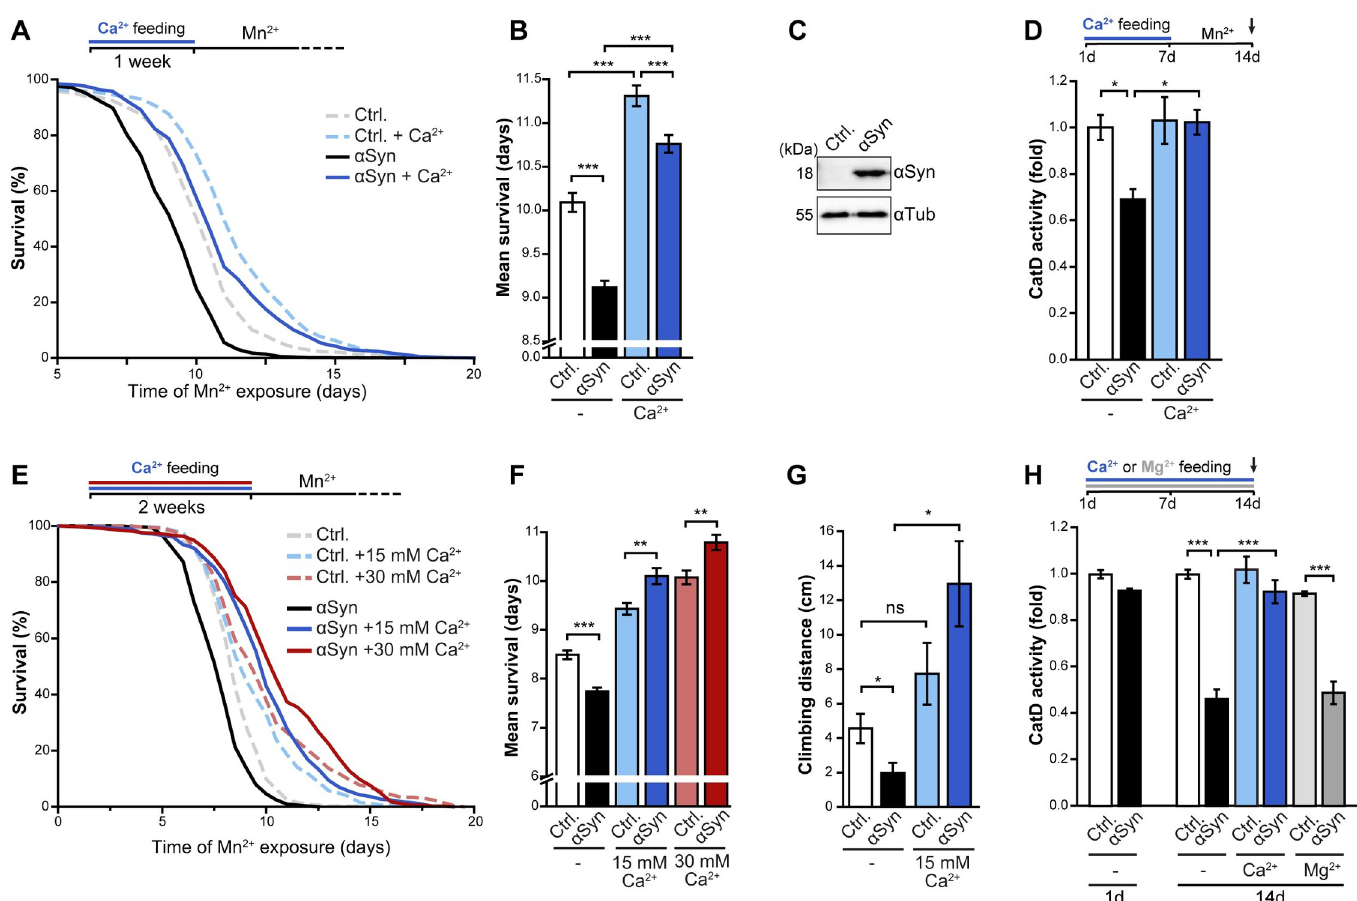
Fig 6. Administration of Ca 2+ activates Cathepsin D in Drosophila and prevents α Syn proteotoxicity. ( A-B ) Survival of flies neuronally expressing human α Syn (UAS- α Syn) driven by nsyB-Gal4 and corresponding control flies upon exposure to 10 mM Mn 2+ . 1–3 days old female flies were collected and kept on food with or without additional 15 mM Ca 2+ for 1 week prior to Mn 2+ exposure. Kaplan-Meier survival analysis (A) and corresponding mean survival (B) is shown. In total, 470–560 flies per genotype and condition were evaluated, and 30 flies were kept per vial. (Genotypes: Ctrl. = Nsyb-Gal4 > w 1118 ; α Syn = Nsyb-Gal4 > UAS- α Syn). ( C ) Immunoblot analysis of head lysates from flies described in (A). Blots were probed with antibodies directed against α Syn and tubulin ( α Tub) as loading control. ( D ) Biochemical measurement of cathepsin D (CatD) proteolytic activity in head lysates of flies described in (A). Prior to Mn 2+ stress, flies were kept on food with or without additional 15 mM Ca 2+ for 1 week. Heads were collected after 7 days of Mn 2+ treatment. Means ± s.e.m; n = 6–7. (E-F) Survival of flies neuronally expressing α Syn (UAS- α Syn) driven by nsyB-Gal4 and corresponding control flies upon exposure to 10 mM Mn 2+ . 1–3 days old female flies were collected and kept on food with or without additional 15 mM Ca 2+ or 30 mM Ca 2+ for 2 weeks prior to Mn 2+ exposure. Kaplan-Meier survival analysis (E) and corresponding mean survival (F) is shown. In total, 340–400 flies per genotype and condition were evaluated, and 30 flies were kept per vial. ( G ) Climbing activity of flies described in (E) after 6 days of Mn 2+ treatment. Means ± s.e.m; n = 6 with 6–8 flies per vial. ( H ) Biochemical measurement of CatD proteolytic activity in head lysates of flies neuronally expressing α Syn (UAS- α Syn) driven by nsyB-Gal4 and corresponding control flies. Heads were collected at day 1 (on standard food without additional Ca 2+ or Mg 2+ supplementation) and after 14 days, during which flies were kept on food supplemented with either 15 mM Ca 2+ , 15 mM Mg 2+ or without supplementation as indicated. Means ± s.e.m; n = 4. � p < 0.05, �� p < 0.01, ��� p < 0.001, and n . s . not